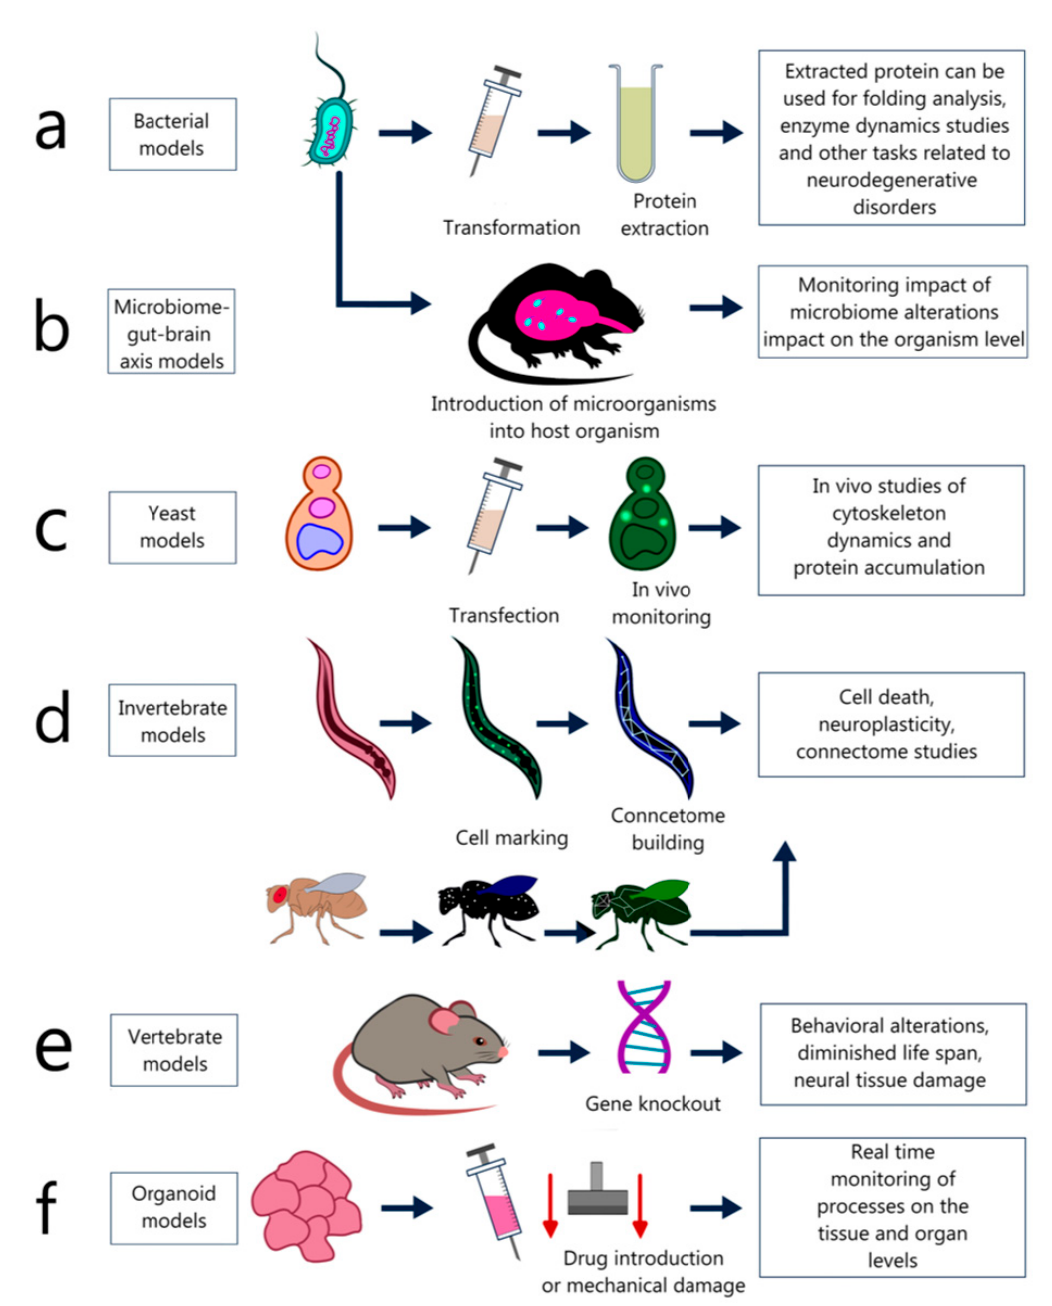
Figure 5. Examples of models used to study neurodegenerative diseases: ( a ) Prokaryotic organisms are used to produce various neurodegeneration associated proteins (‘protein factories’); ( b )